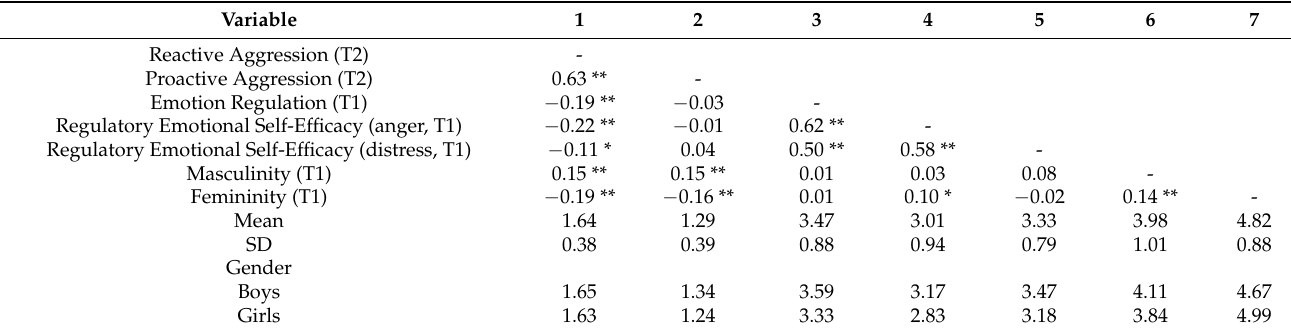
Note: * p < 0.05; ** p < 0.01; regulatory emotional self-efficacy (anger) = perceived self-efficacy in managing anger/irritation; regulatory emotional self-efficacy (distress) = perceived self-efficacy in managing despondency/distress; SD = standard deviation; 1 = reactive aggression (T2); 2 = proactive aggression (T2); 3 = emotion regulation (T1); 4 = regulatory emotional self-efficacy (anger, T1); 5 = regulatory emotional self-efficacy (distress, T1); 6 = masculinity (T1); and, 7 = femininity